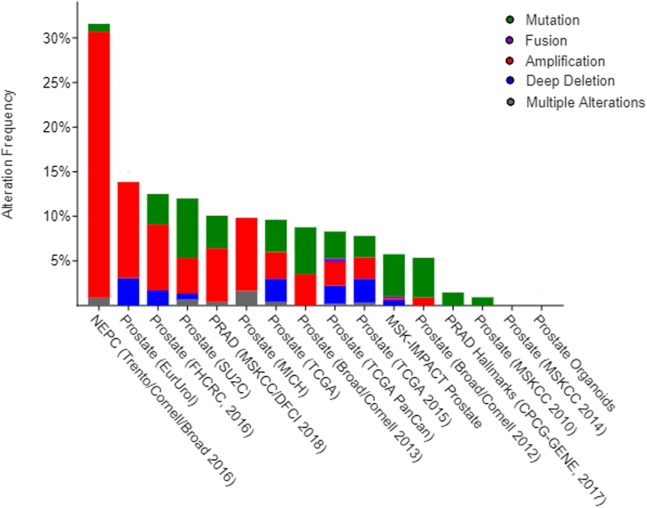
Overview of changes on ESR1, PIK3CA, AKT1, and MAPK1 genes in genomics data sets available in 16 different prostate cancer studies.